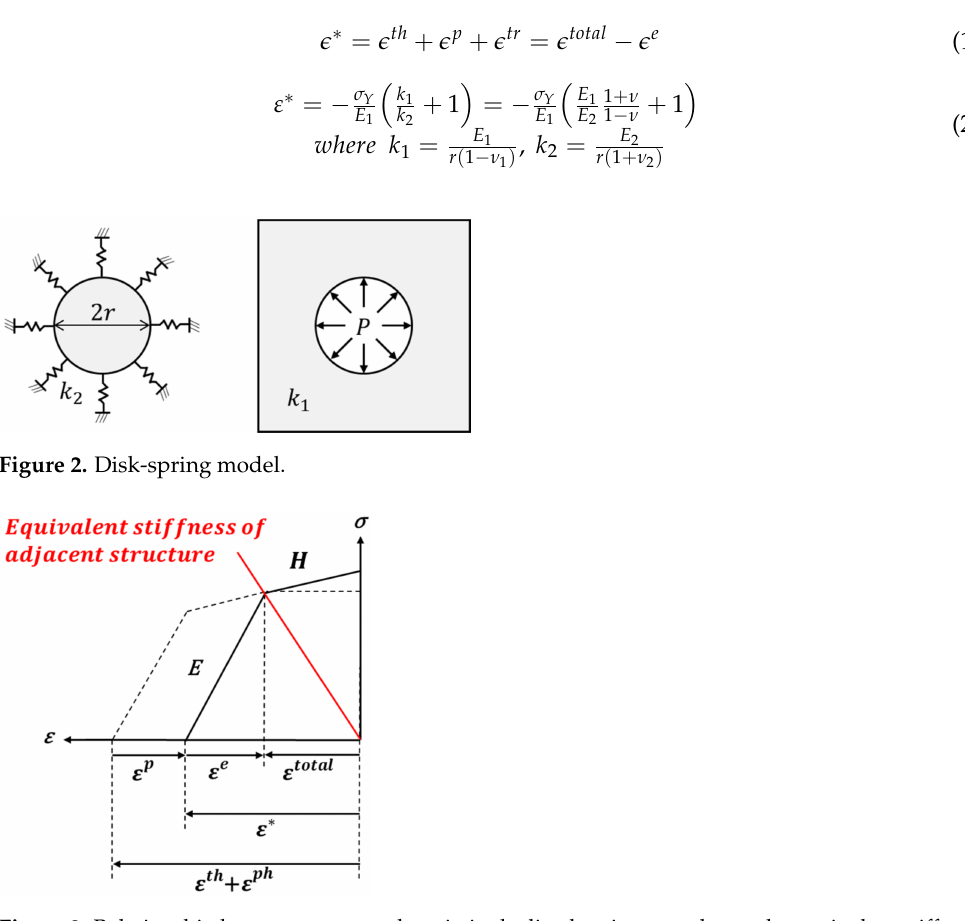
Figure 3. Relationship between stress and strain in the line heating area due to the equivalent stiffness of the adjacent